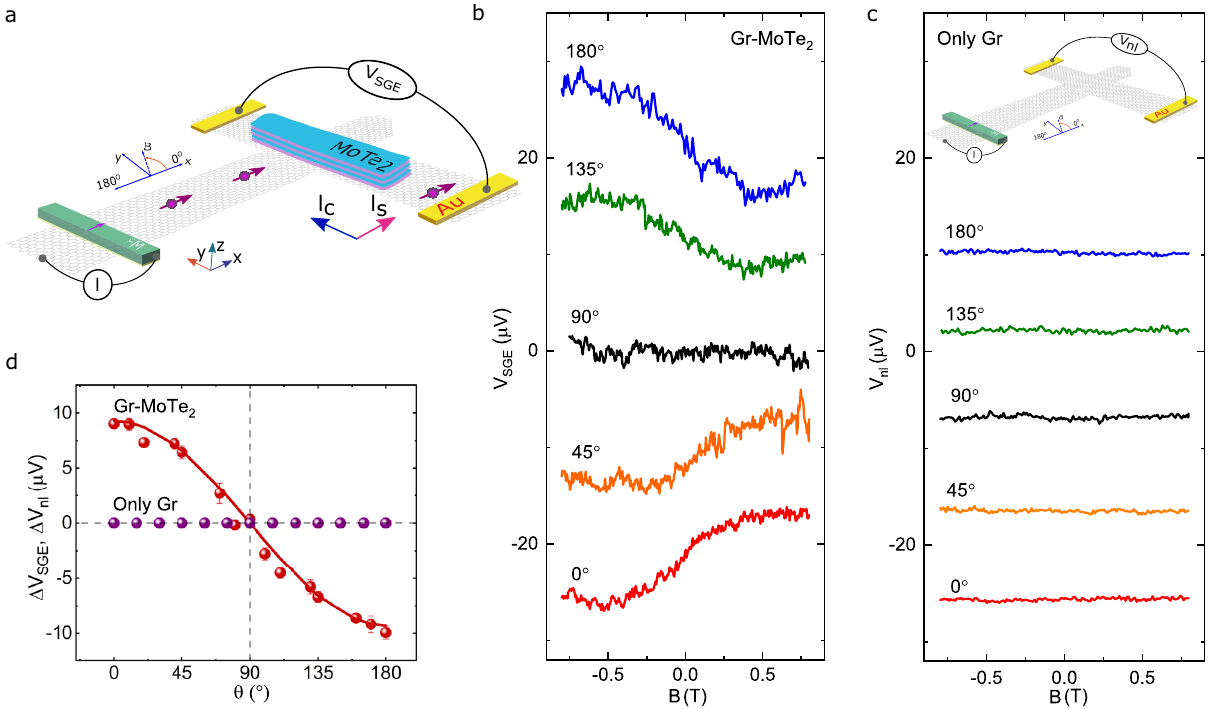
Fig. 2 Angle dependence of spin-galvanic signal in the graphene-MoTe 2 heterostructure. a A schematic illustration of the spin-galvanic signal measurement geometry with directions of an applied magnetic fi eld ( B ), the injector ferromagnet magnetization ( M ), the spin current ( I s ), and external magnetic fi eld angle ( θ ) in x – y plane. b The manifested spin-galvanic signal ( V SGE ) as a function of the magnetic fi eld ( B ) sweep for various measurement angle ( θ ) orientations in the x – y plane, with an application of I = 60 µ A in Dev 2 at room temperature. A linear background is subtracted from the data and shifted in the y -axis for clarity (see Supplementary Fig. S8). c As a control experiment, the non-local signal as a function of magnetic fi eld sweep (B) for various in-plane ( x – y plane) measurement angle ( θ ) orientations in only graphene Hall cross at room temperature with I = 100 μ A and V g = − 50V along with the measurement geometry in the inset. The signals are shifted in the y -axis for clarity. d The magnitude of spin-galvanic signals ( Δ V SGE ) in graphene-MoTe 2 heterostructure and non-local signal ( V nl ) in the only graphene as a function of the applied magnetic fi eld angle ( θ ). The solid line is the cos( θ ) function. The error bars are calculated from the noise level of the manifested signals and not clearly visible because error bars are smaller than the data